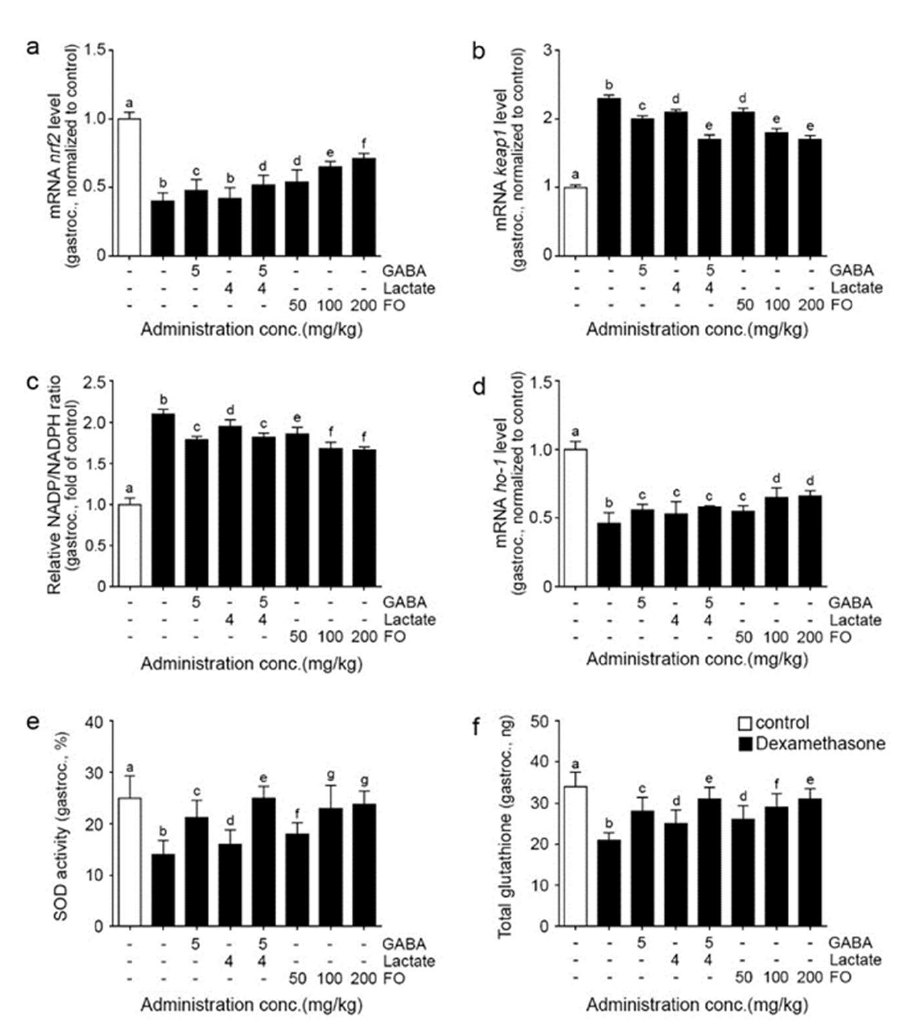
Figure 1. FO reduced ROS through Nrf2/Ho-1 in the gastrocnemius muscle atrophy induced mouse model; ( a ) The mRNA levels of nrf2 were decreased by Dexa/Saline but increased by GABA, lactate, GABA+lactate, and FO treatment; ( b ) The mRNA levels of keap1 were increased by Dexa/Saline but decreased by GABA, lactate, GABA+lactate, and FO treatment; ( c ) Relative NADP/NDPH ratios were increased by Dexa/Saline but decreased by GABA, lactate, GABA+lactate, and FO treatment; ( d ) The mRNA levels of ho-1 were decreased by Dexa/Saline but increased by GABA, lactate, GABA+lactate, and FO treatment; ( e , f ) SOD activity ( e ) and total glutathione ( f ) were decreased by Dexa/Saline but increased by GABA, lactate, GABA+lactate, and FO treatment. Different letters, a–g, indicate significant differences among the group as determined by multiple comparisons (Mann-Whitney U test); p < 0.05; fermented oyster extracts (FO); γ-aminobutyric acid (GABA); heme oxygenase (ho-1); gastrocnemius (gastroc.); kelch-like ECH-associated protein 1 (keap1); nicotinamide adenine dinucleotide phosphate (NADP); nicotinamide adenine dinucleotide phosphate hydrate (NADPH); nuclear factor erythroid-2-related factor 2 (nrf); superoxide dismutase (SOD).